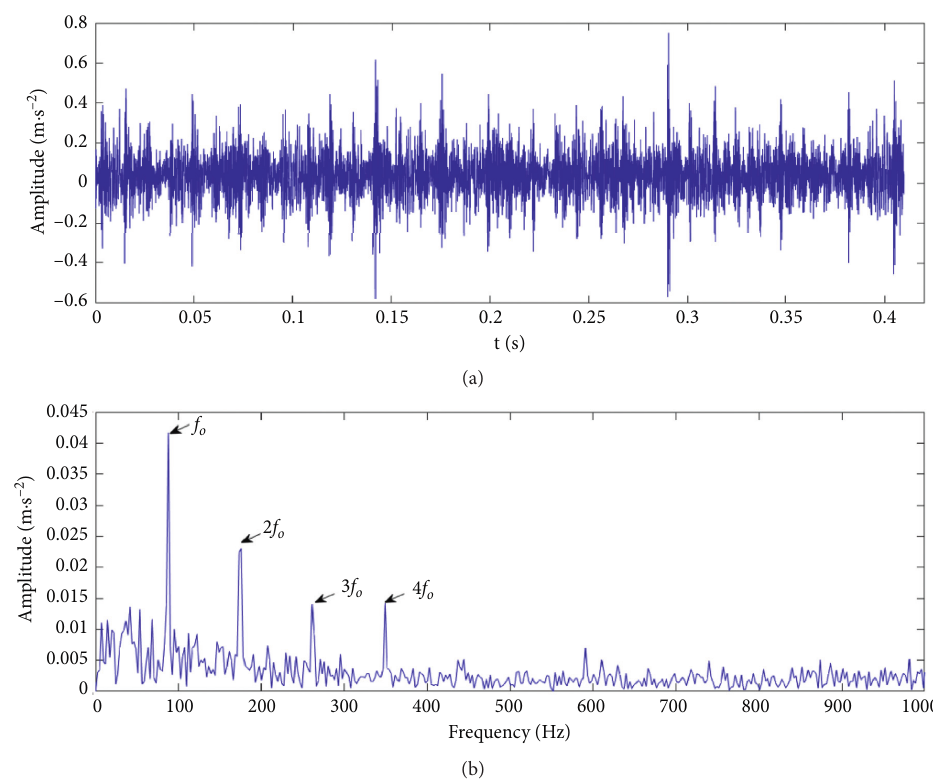
Figure 17: Waveform and envelope spectrum of compound fault signal. (a) Waveform of fault signal. (b) Envelope spectrum of fault signal.